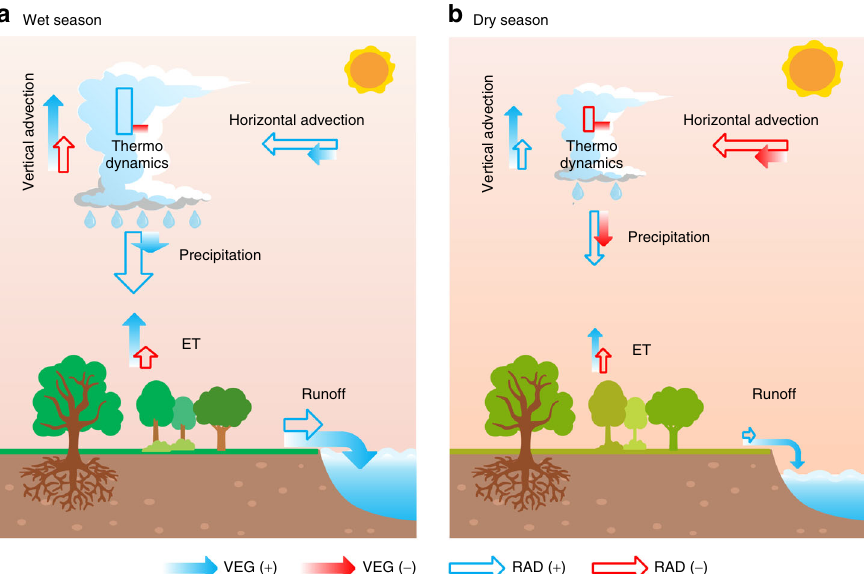
Fig. 4 Schematic diagram of the mechanisms driving seasonal monsoon precipitation and runoff changes in the fi ve monsoon regions with annual precipitation increase. Changes in precipitation, runoff and evapotranspiration (ET) in a wet and b dry seasons. Precipitation change is divided into thermodynamic effect, vertical advection, horizontal advection and land ET components as marked (see also Methods section). The solid and open arrows (or rectangles) represent the vegetation-physiological (VEG) and radiative forcings (RAD) of rising CO 2 in each process, respectively. The blue or red colour indicates if the change is bene fi cial ( + ) or adverse ( − ) to runoff change, respectively, rather than the sign of the change itself. The size of the arrows (or rectangles) denotes the relative magnitude of each change averaged over the fi ve monsoon regions (hence excluding North and South America). The signs of precipitation and its component changes are generally consistent among the fi ve monsoon regions, although there are a small number of exceptions (Supplementary Table 3). In the wet season a , RAD-induced warming dominates the increases in atmospheric precipitable water, advection and precipitation, although VEG forcing via rising CO 2 also increases precipitation by enhancing atmospheric circulation (vertical advection and horizontal advection). VEG-induced land ET reduction and precipitation increase result in more water fl owing as runoff. In the dry season b , RAD-induced increases in vertical advection and land ET overcome the negative impacts of horizontal advection and thermodynamic decreases, facilitating precipitation increase, although VEG exerts an adverse impact on precipitation. However, VEG-induced ET decrease still drives an increase in